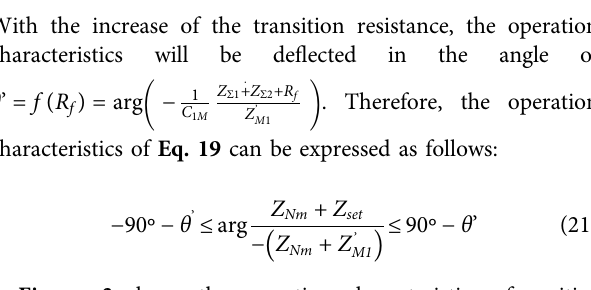
Frontiers in Energy Research |